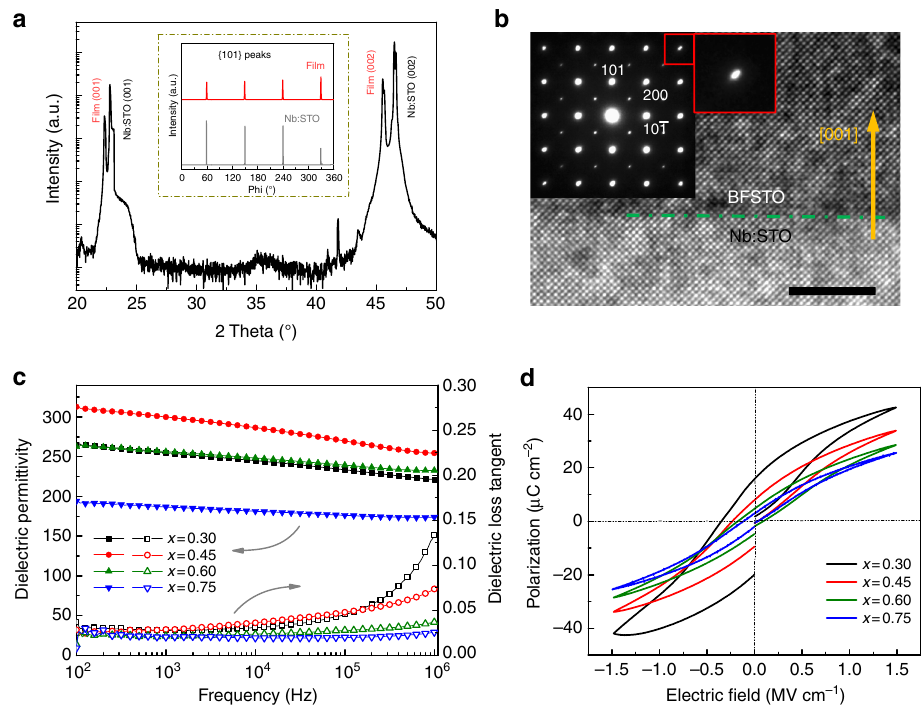
Fig. 2 Microstructure, dielectric, and ferroelectric properties. a XRD pattern of the BFSTO fi lm with x = 0.45; the insets shows the phi scans of its {101} planes corresponding to the Nb:STO substrate. b A high-resolution TEM image of the interface of BFSTO fi lm with x = 0.45 and Nb:STO substrate (scale bar: 5 nm); the inset is the SAED pattern at the interface zone. c Frequency-dependent dielectric permittivity and loss tangent and d bipolar P – E loops of the BFSTO fi